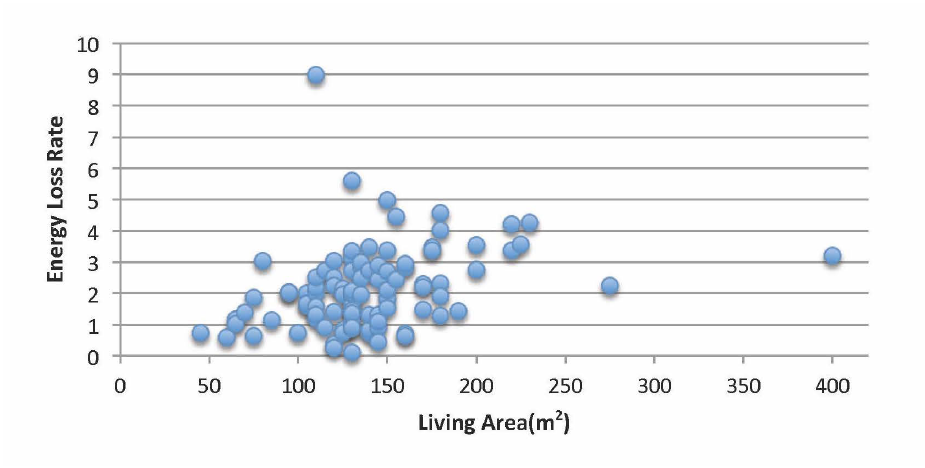
Figure 10. Relation between size of the house and estimated value for heat loss